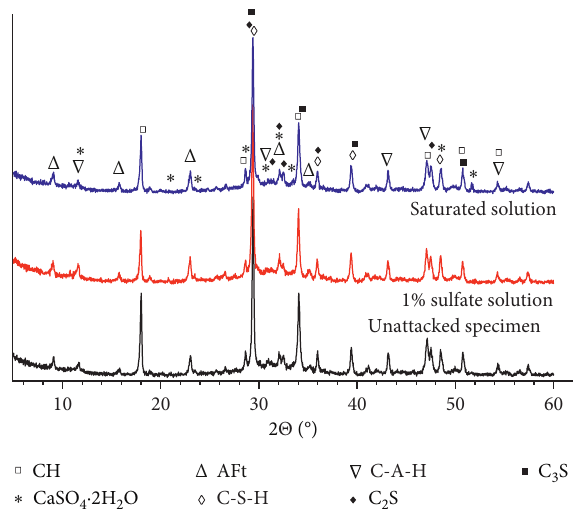
Figure 7: XRD spectra of phase composition of specimens attacked by sulfate